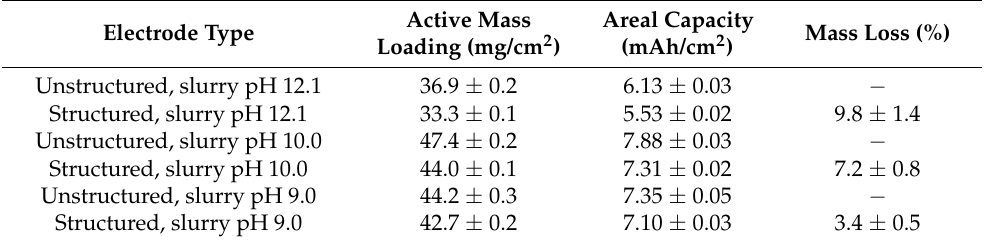
Table 2. Active mass loading, areal capacity, and respective mass loss of laser structured electrodes compared to unstructured ones.